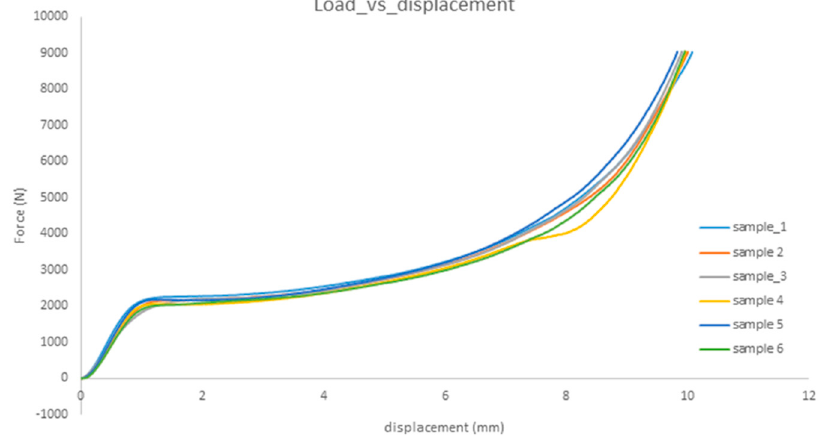
Figure 7. Results of force-displacement for samples of bone cement with nanoparticles; sample 1—pure bone cement; sample 2—Ag; sample 3—Cu10; sample 4—Cu70; sample 5—AgCu; sample 6—Ni.